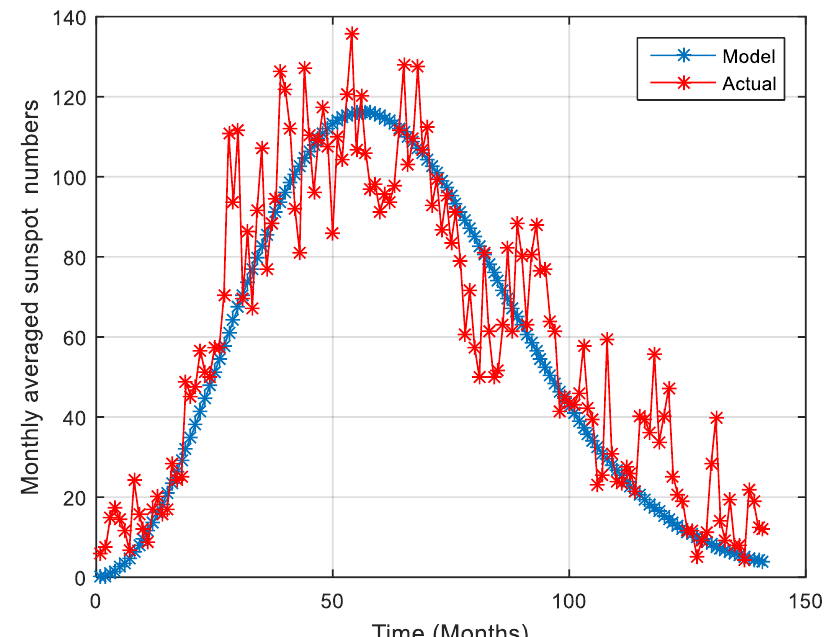
Figure-4. Fitting of sunspot cycle 20 by the